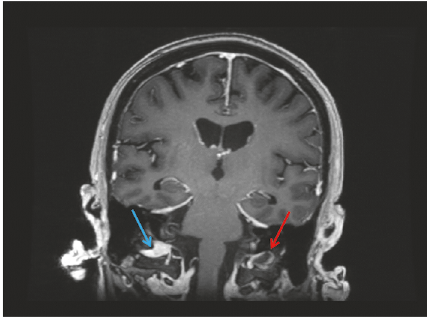
Figure 6: Coronal reformatted postcontrast FSPGR sequence demonstratingfillingdefectwithintheleftsigmoidsinus.Bluearrow is demonstrating a normal right vein. Red arrow is demonstrating clot within the left vein.